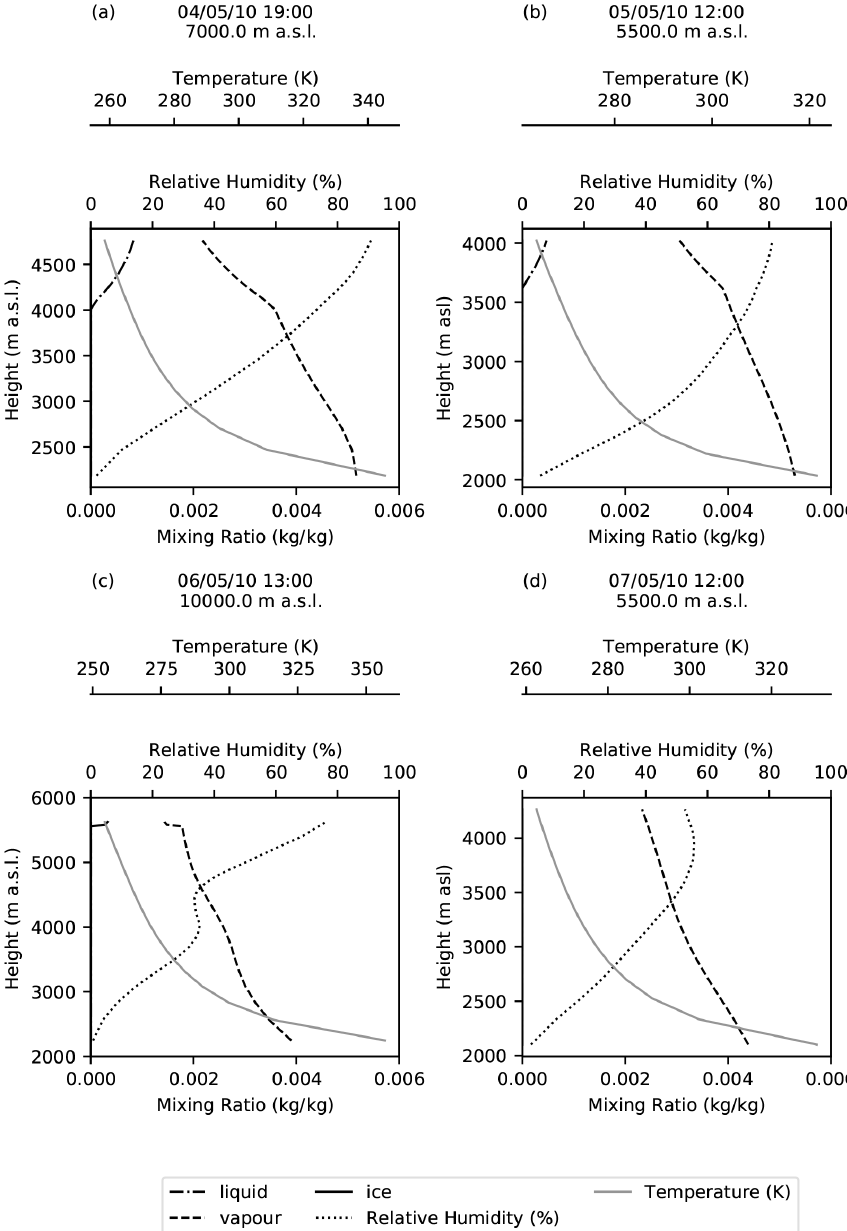
Figure 1. Mixing ratios of water vapour ( n v / n d ), liquid water ( n l / n d ), and ice ( n ice / n d ) with height along the buoyant plume axis, for the eruption of Eyjafjallajökull volcano between 4 and 7 May 2010. Also shown are the relative humidity and temperature. Note the variation in axis scales. The maximum height of the modelled plume axis, when the plume is bent over as in this case, is the maximum observed plume height (provided in the figure titles) minus the plume